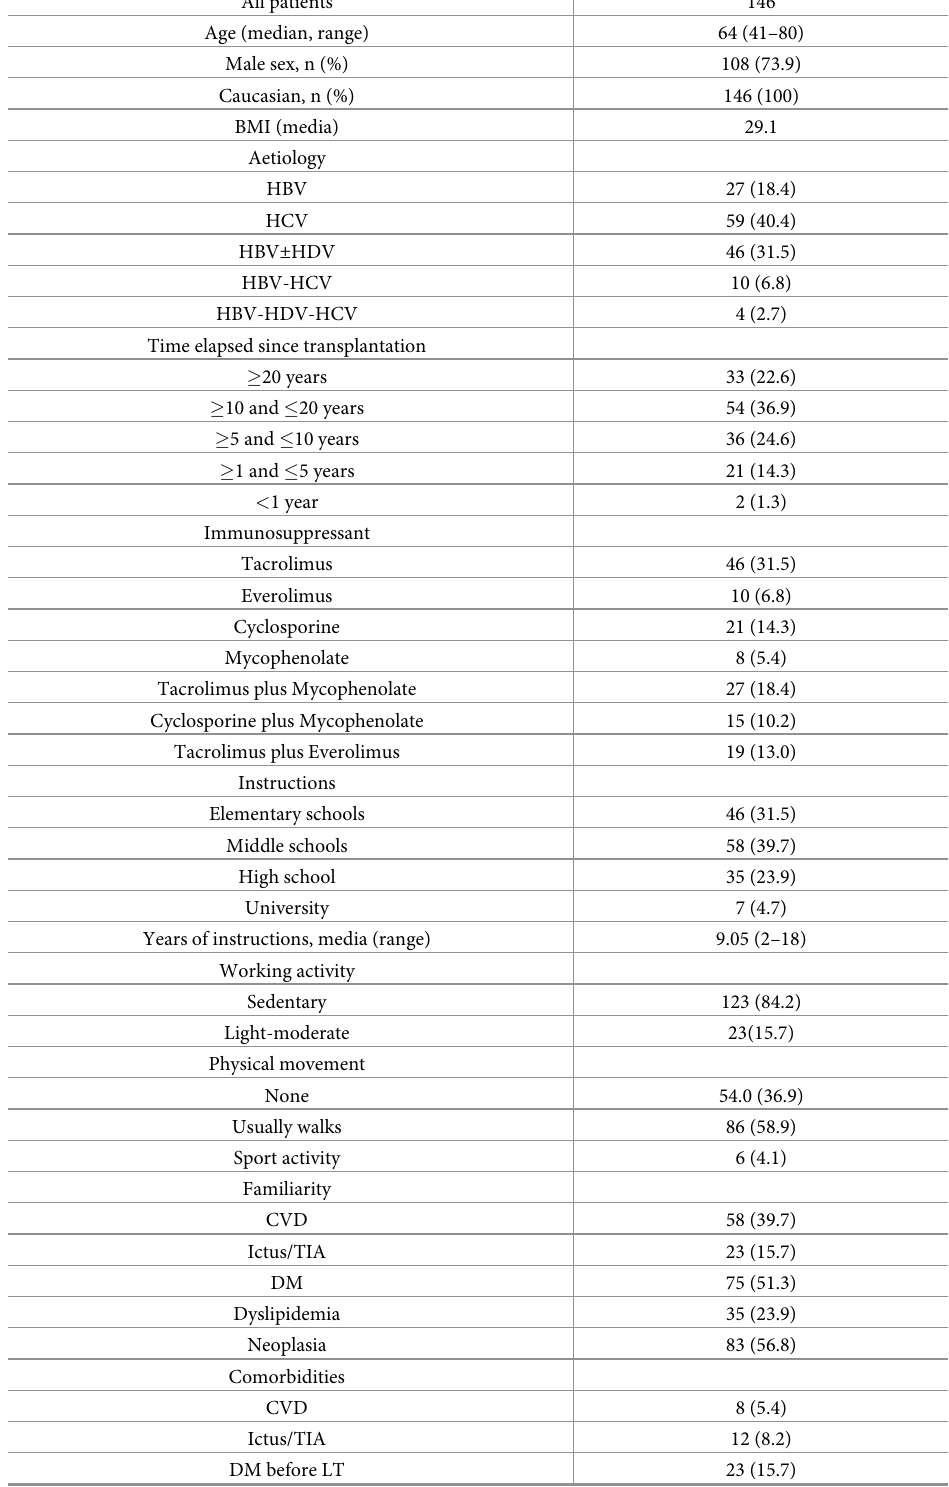
Table 1. Demographics and data regarding transplant status and CVD risk n, (%). All